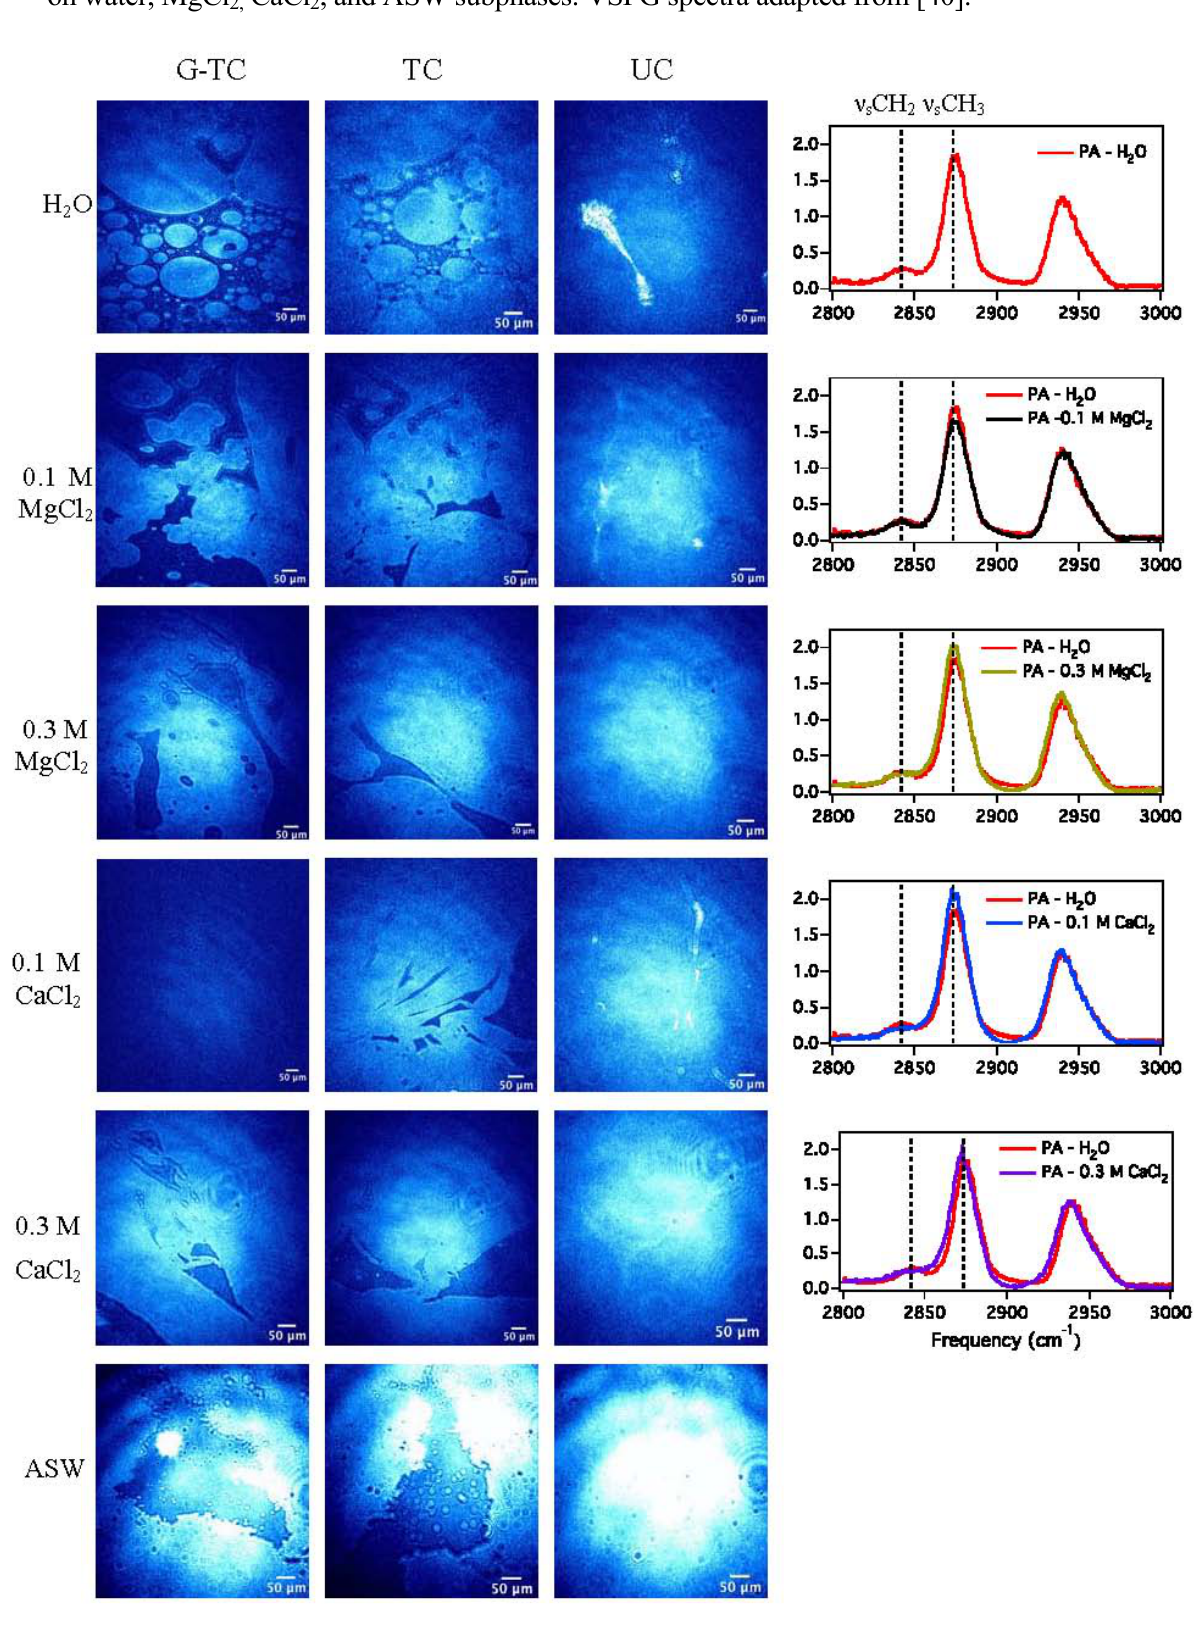
Figure 3. Brewster angle microscopy (BAM) images in various phases and vibrational sum frequency generation (VSFG) spectra in the CH region (2,800–3,100 cm − 1 ) of PA monolayer on water, MgCl CaCl , and ASW subphases. VSFG spectra adapted from 2, 2